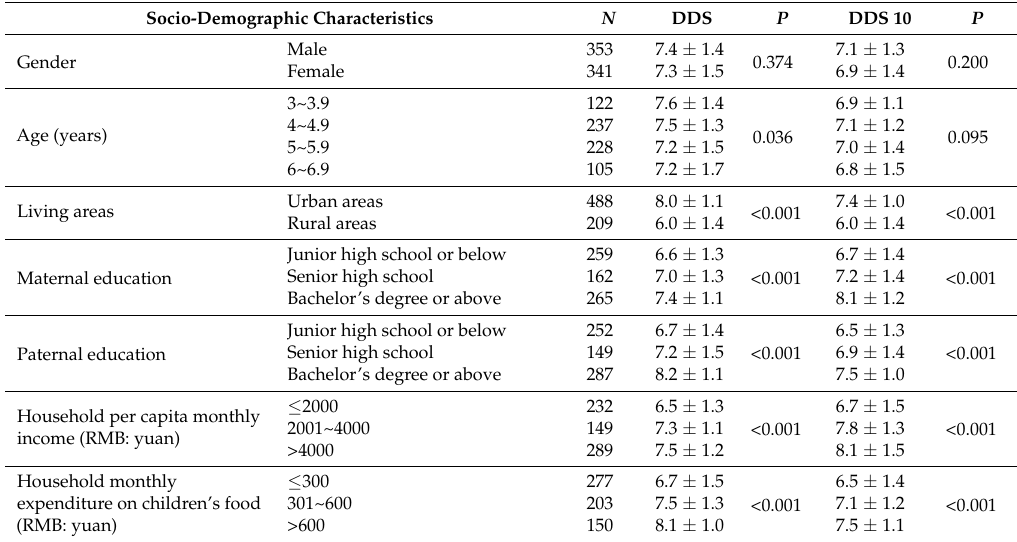
Table 2. The DDS and DDS 10 among Chinese preschool children with different socio-demographic characteristics (Mean ± standard deviation (SD)).